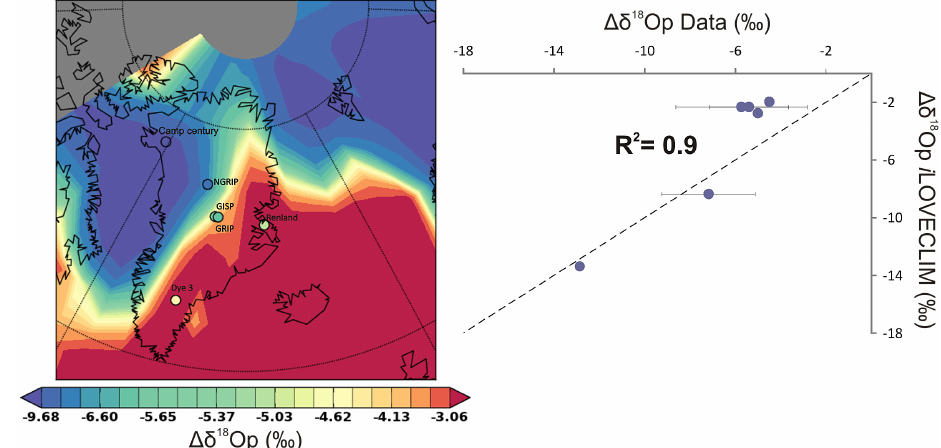
Figure 2. Comparison between simulated precipitation δ 18 O anomaly (LGM-CT) in i LOVECLIM and ice core data from Greenland (Ta- ble 1). Reported uncertainties on data are 2 σ . For colour scale generation explanations see Fig. 1 caption.